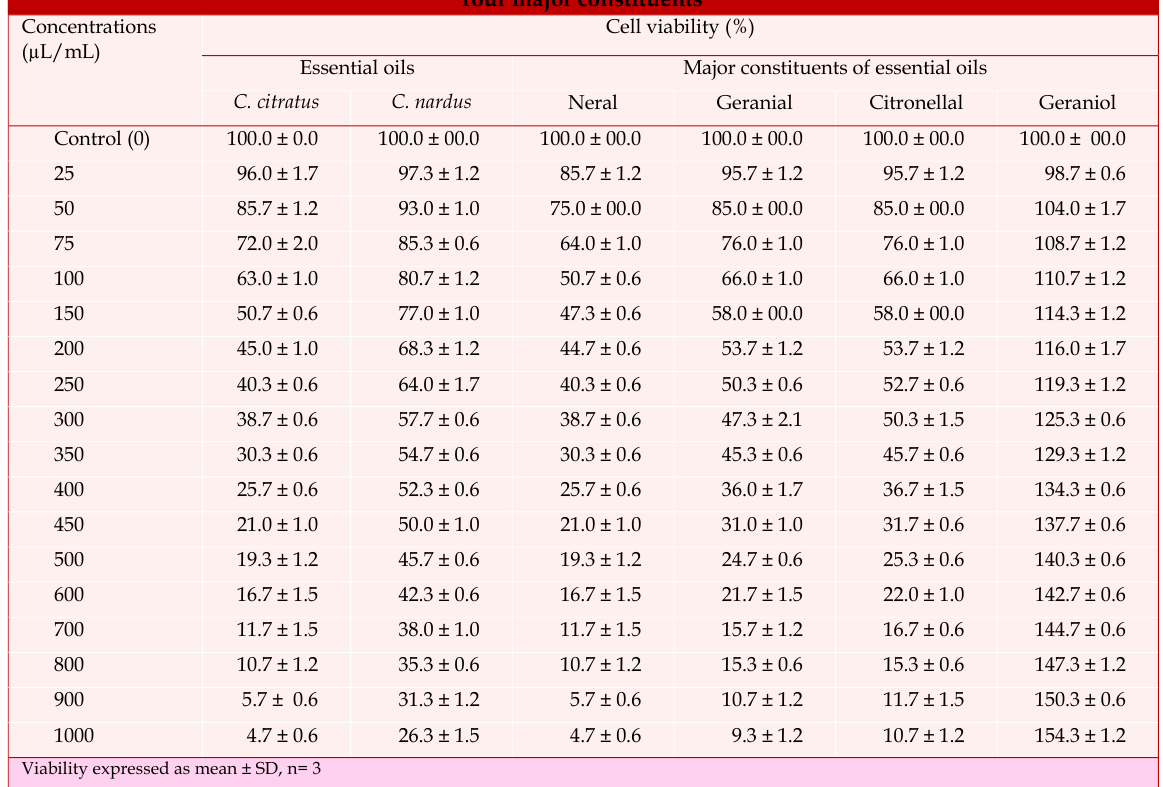
In vitro viability of human skin cell line HaCat exposed to C. citratus and C. nardus essential oils and